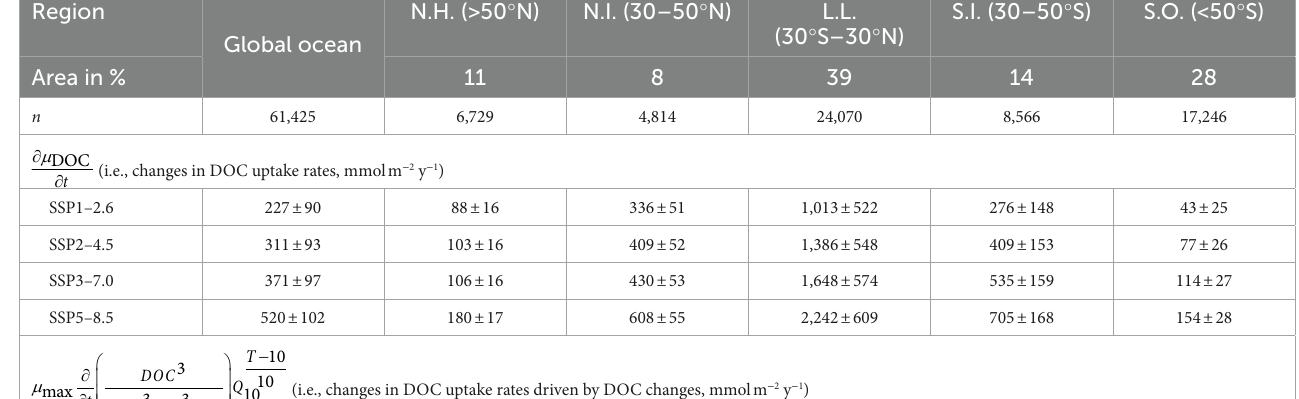
TABLE 2 The first-order Taylor decomposition of changes in DOC uptake rates of free-living bacteria under different climate change scenario.